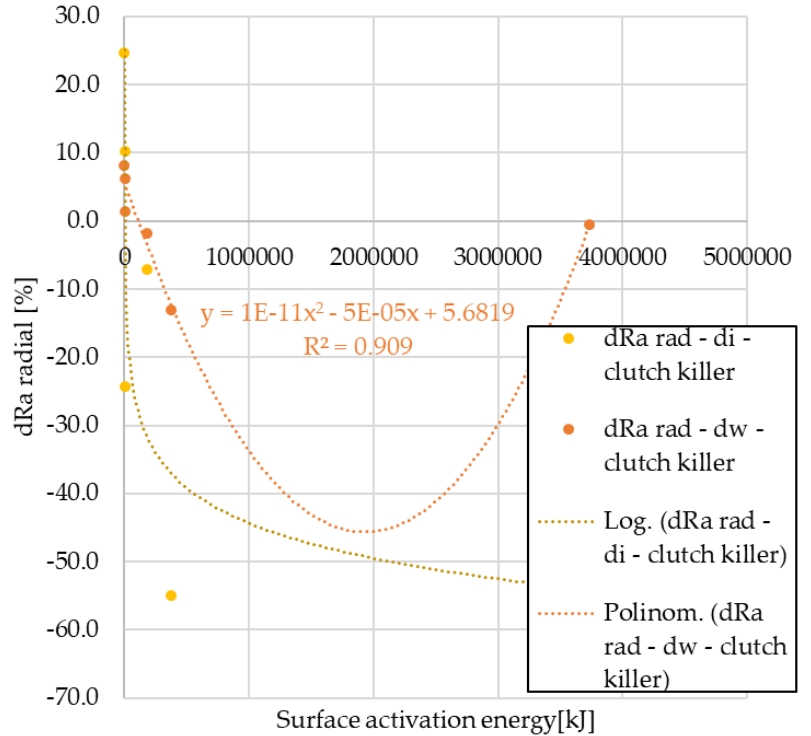
Figure 11. Variation of radial Ra values as a function of activation energy — clutch killer facings.